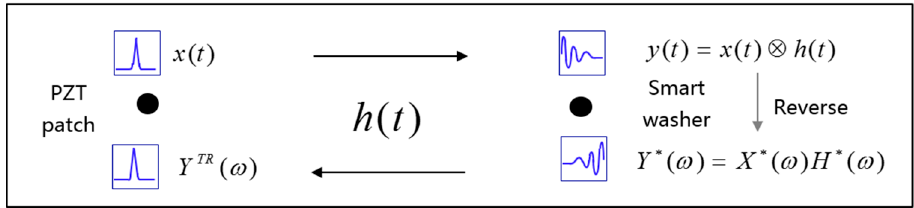
Figure 2. The schematic of time reversal method for active sensing.